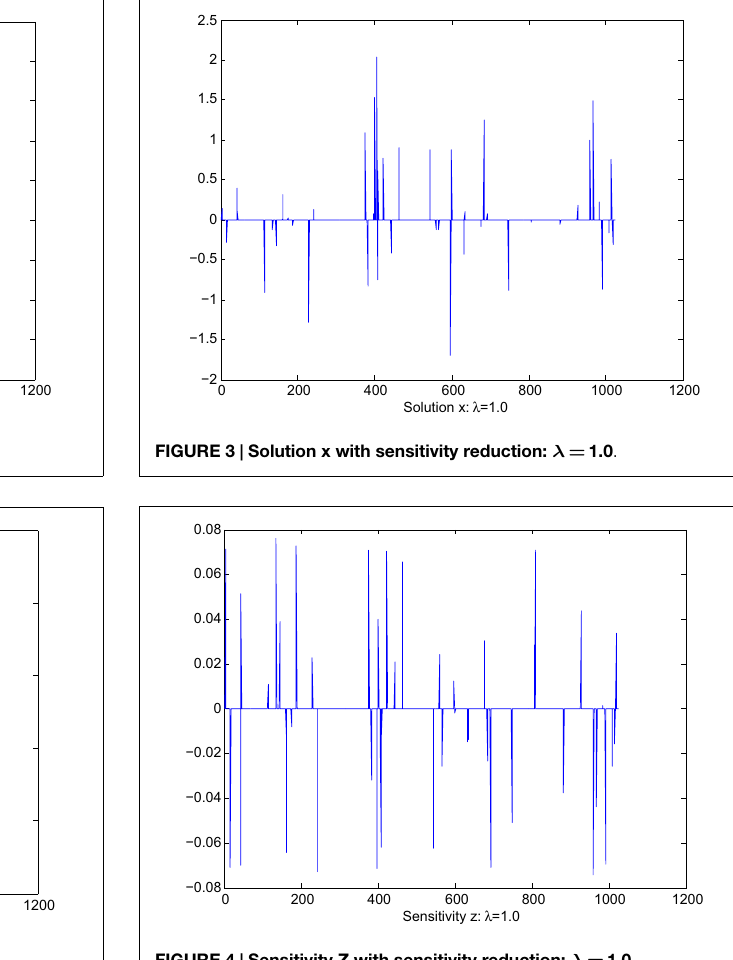
FIGURE 2 | Sensitivity Z without sensitivity reduction: (cid:21) = 0 .